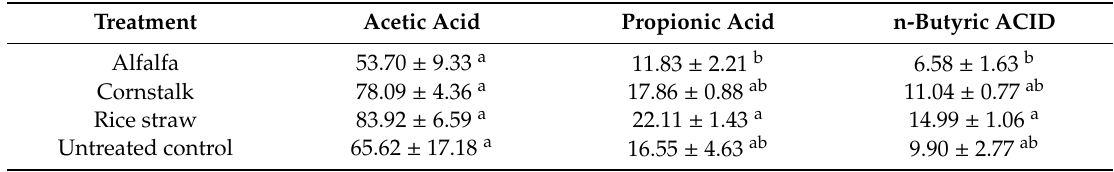
Table 5. Volatile fatty acid concentration (mmol /